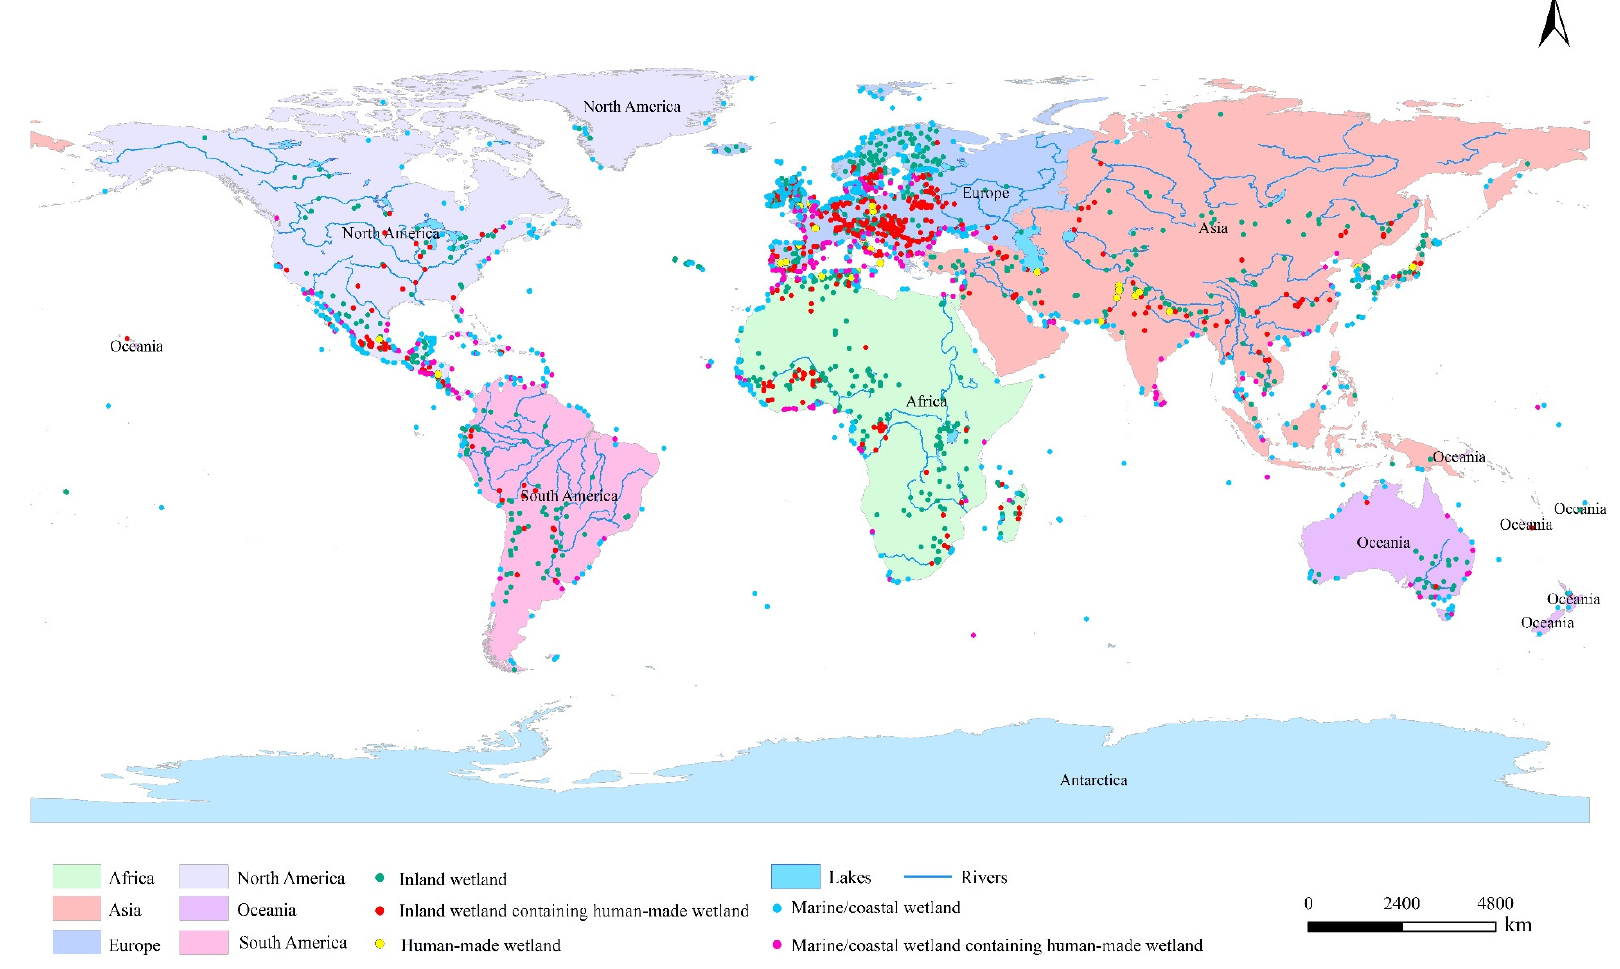
Figure 3. The distribution map of the Ramsar Sites. By referring to the free data obtained from the Ramsar’s official website, the authors use the Arcgis 10.2 software (ESRI (Environmental Systems Research Institute, Inc.), Redlands, CA, USA) to draw Figure 3. The data source is Reference [28].